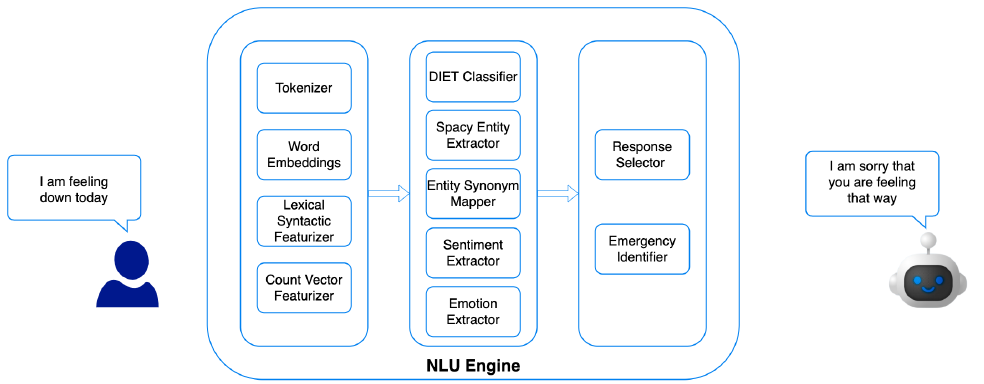
Figure 2. NLP engine for personalised conversations with the BA-based AI